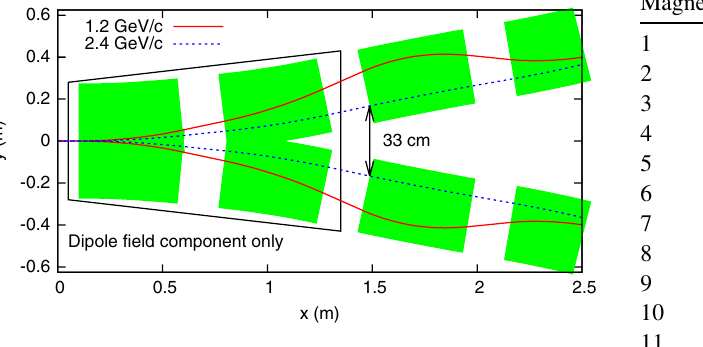
FIG. 2. The apex of the droplet arc with the pure dipoles acting as a spreader/recombiner of the different-momentum trajectories.